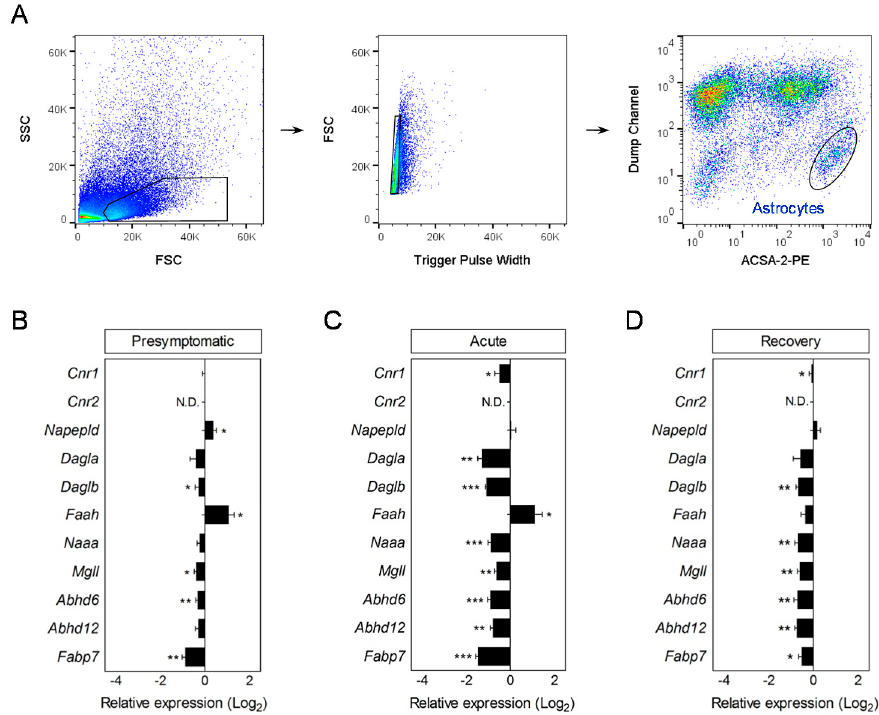
Figure 1. Early-onset deregulation of endocannabinoid system genes in astrocytes during EAE. ( A ) Representative dot-plots depicting FACS strategy for the purification of astrocytes from the CNS of EAE mice. Astrocytes were sorted as ACSA-2 + cells following the exclusion of contaminating microglia / macrophages and hematopoietic cells (CD11b + / CD45 + ), oligodendrocytes (O1 + ), oligodendrocyte progenitors (A2B5 + ), and endothelial cells (CD31 + ) grouped in a dump channel. ( B – D ) Histograms represent fold changes in the relative expression of endocannabinoid activity genes in cells sorted during presymptomatic ( B ), acute ( C ), and recovery ( D ) phases of the EAE compared to astrocytes from non-immunized mice purified in parallel ( n = 5–6 mice group). Changes in relative